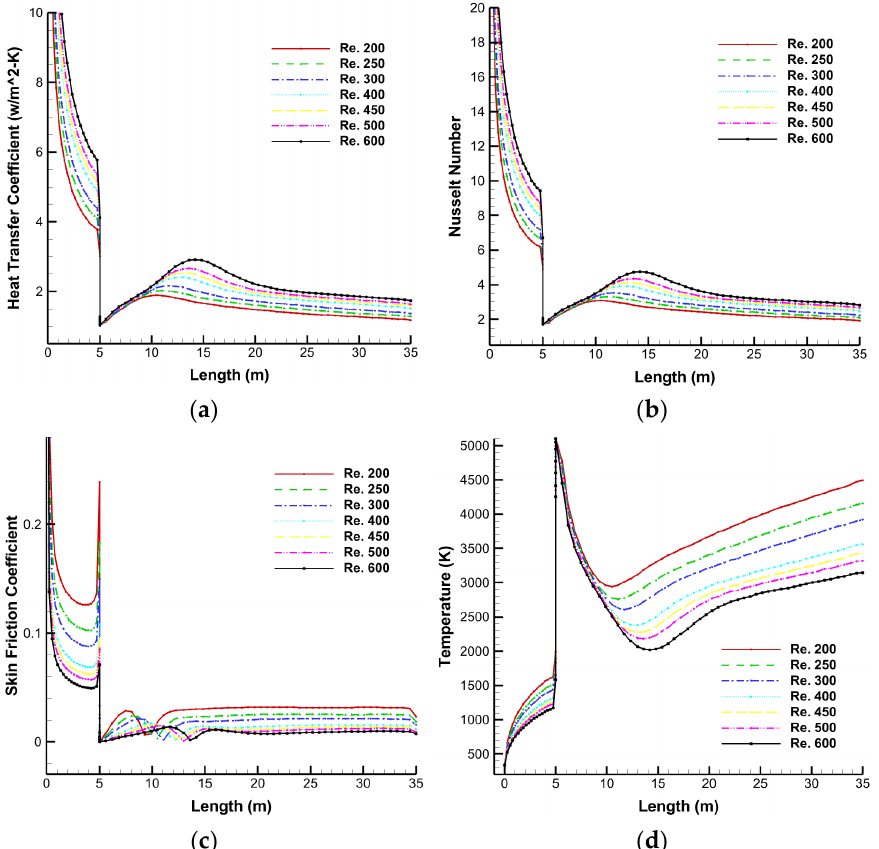
Figure 5. Heat transfer parameters for varying Reynolds numbers: ( a ) heat transfer coefficient, ( b ) Nusselt number, ( c ) skin friction coefficient, and ( d ) temperature.